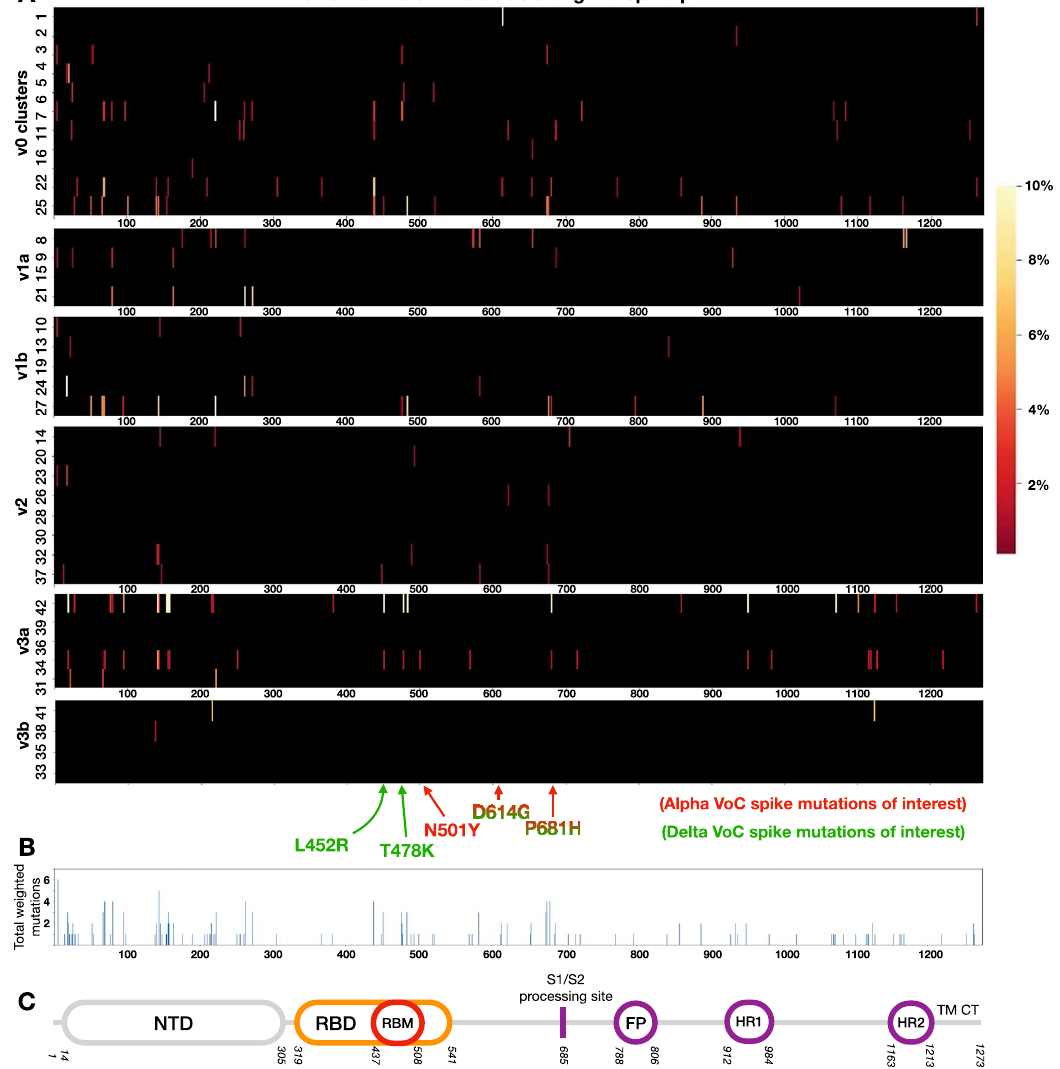
Figure 5. Patterns of spike protein diversification of the emerging variants. Heatmaps indicate for each cluster in a chain ( A ) the location and number of amino acid substitutions counted per all variants in a cluster when compared to the previous cluster and normalised accordingly (see Supplementary material). Subdominant variants in each cluster are retained if their frequency is above 1% in the cluster. ( B ) recapitulates the sum of all the values from all chains in A, while ( C ) shows the S protein structure for